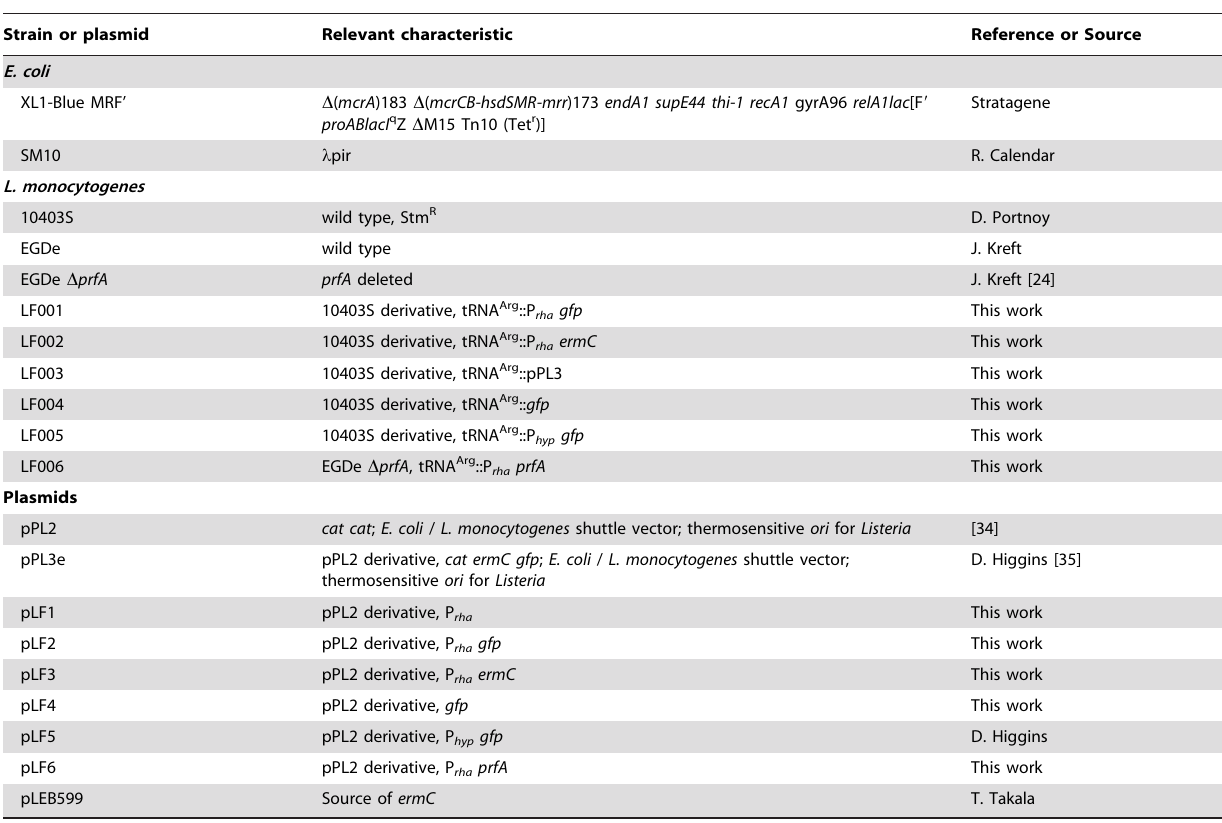
Table 1. Bacterial strains and plasmids used in this